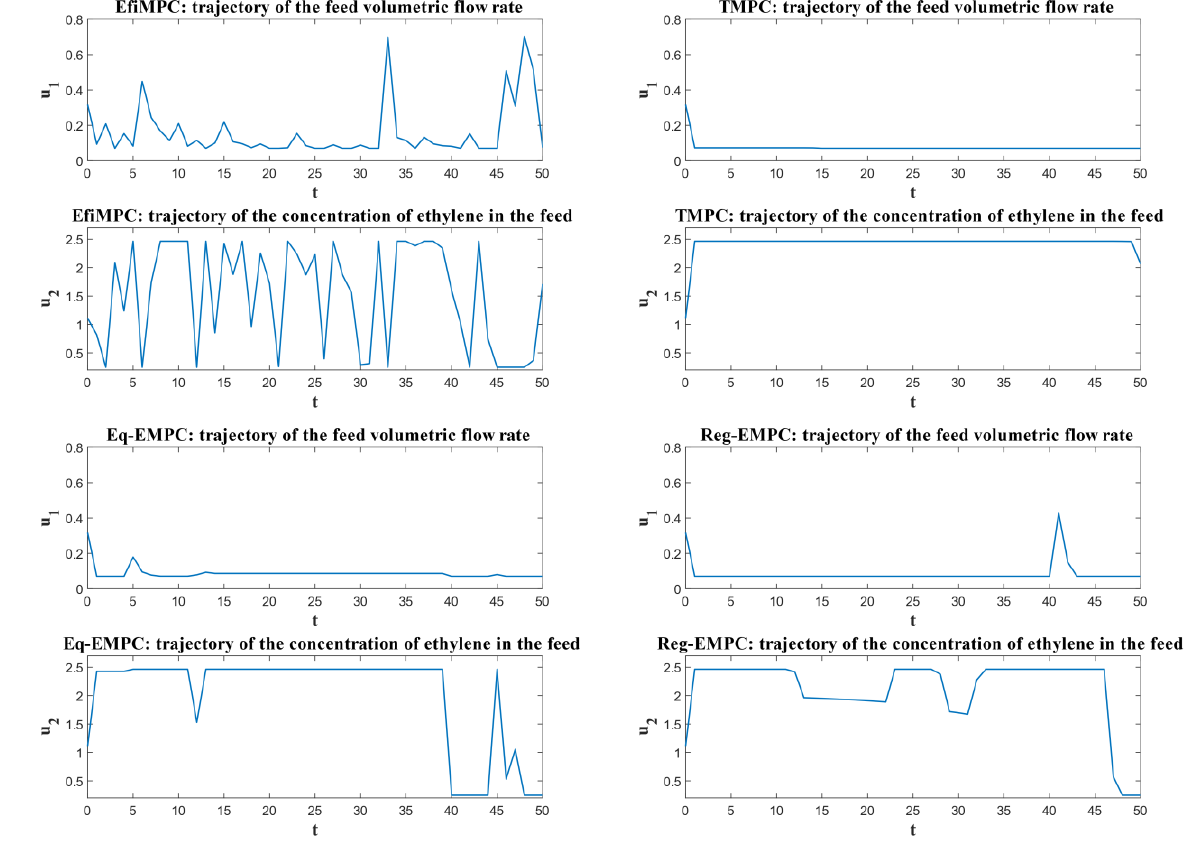
Figure 8. The input trajectories of the comparative control strategies.